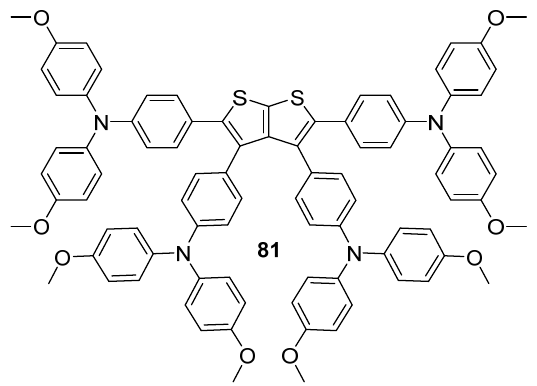
Figure 11. HTM 81 with the central TT 2 unit.